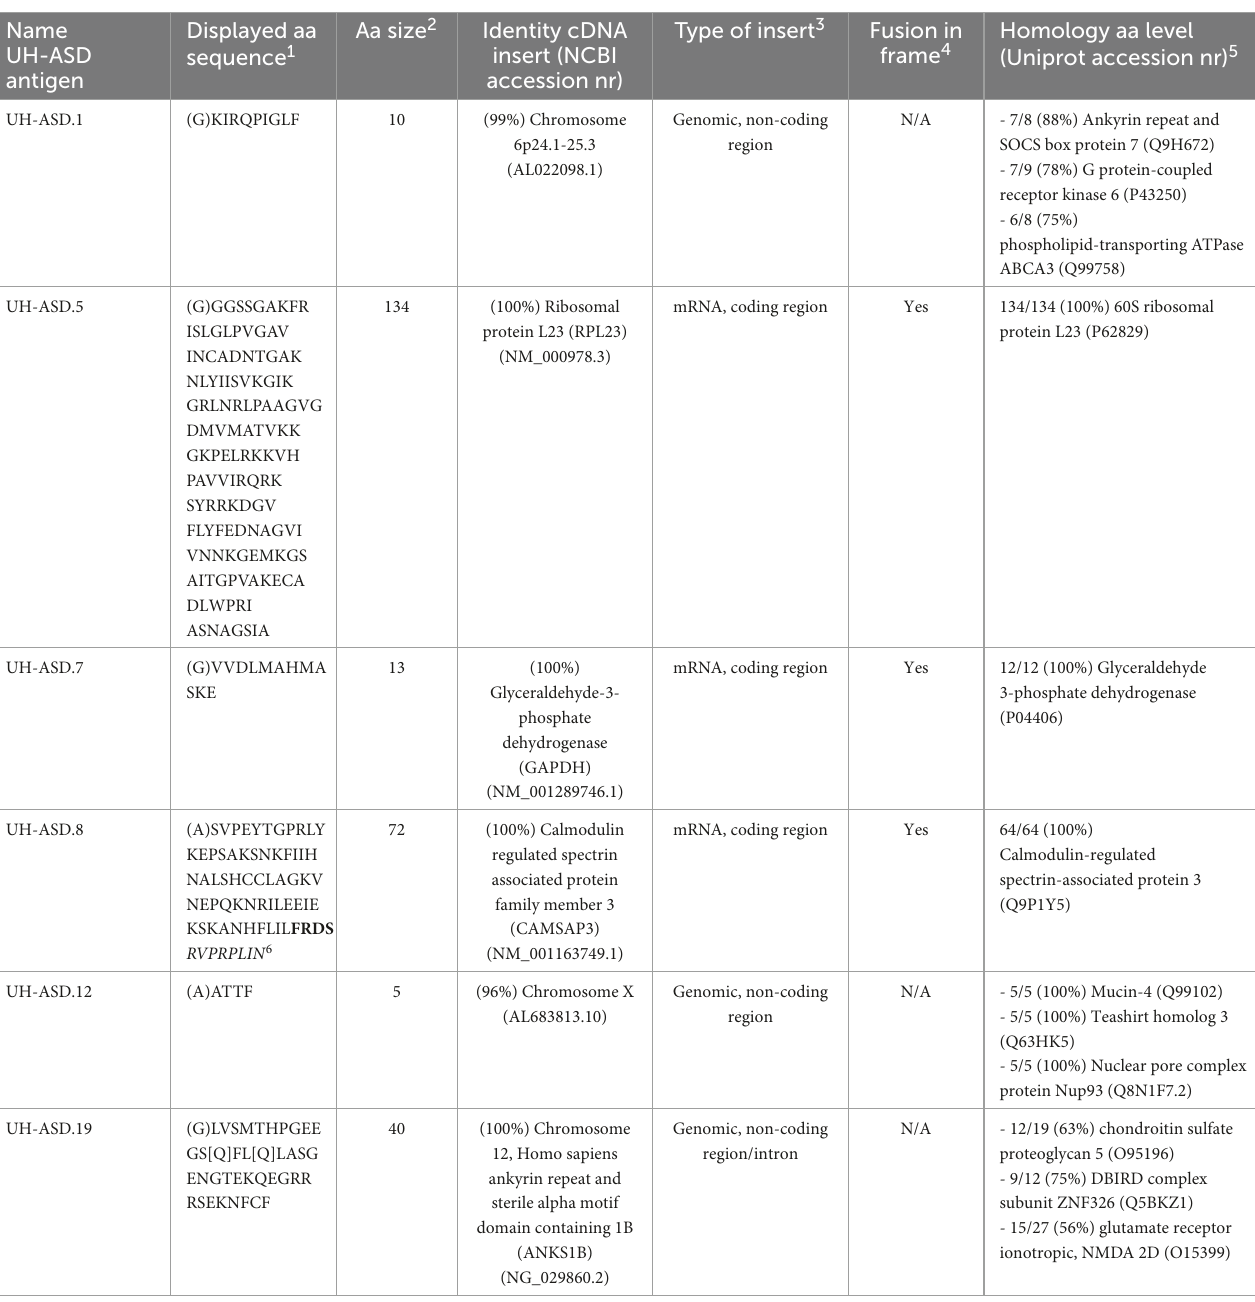
TABLE 2 Sequence, origin and homology of 6 novel UH-ASD antigens. Name UH-ASD antigen